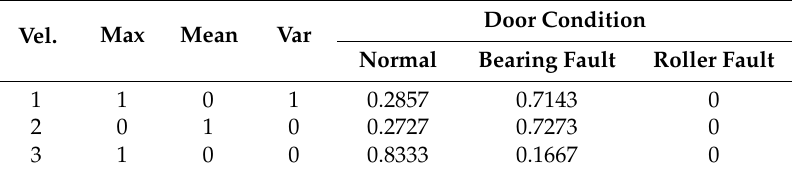
Table 5. Estimation result during one open operation.